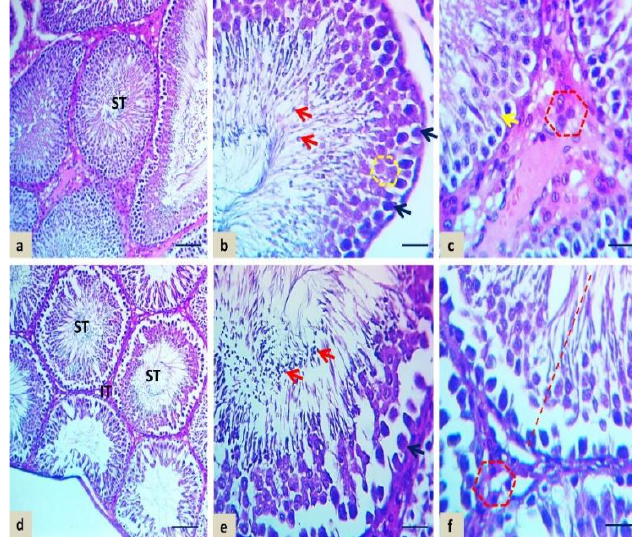
Figure 6. Microscopic photographs of seminiferous tubules sections of the right testis of male Wister rats in negative control ( a-c ) and diabetic control ( d-f ). a , Normal spermatogenic arrangement and cellularity (ST) (H&E, 200×); b , well- organized interstitial space (IT) with intact spermatogenic cells including spermatogonia (black arrows), primary spermatocytes (yellow polygonal) and round spermatids (red arrows) (H&E, 400×); c , intact Sertoli cells (yellow arrows) and Leydig cells (red polygonal) (H&E, 400×). d, Dilated seminiferous tubules (ST) and mild degenerated interstitial space (IT) (H&E, 200×); e , moderate-marked degeneration of spermatid as designated by red arrow (H&E, 400×); f , hypospermatogenesis and vacuolization in spermatogenic cells (red dash line) with degenerated Leydig cells (red polygonal) (H&E, 400×)